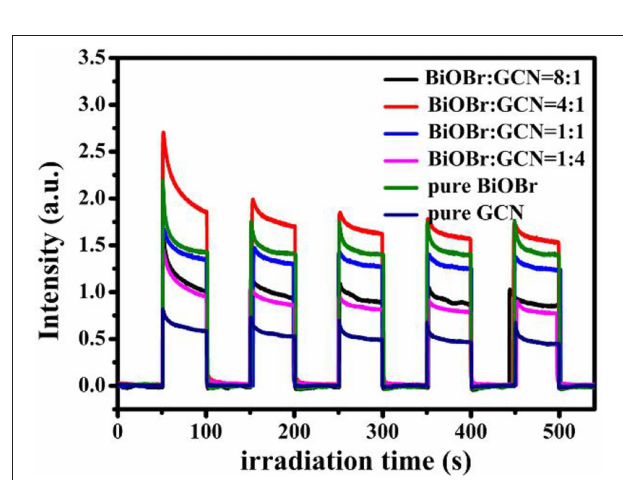
FIGURE 5 | The PL spectra of pure BiOBr and g-C 3 N 4 , BiOBr-g-C 3 N 4 composites.